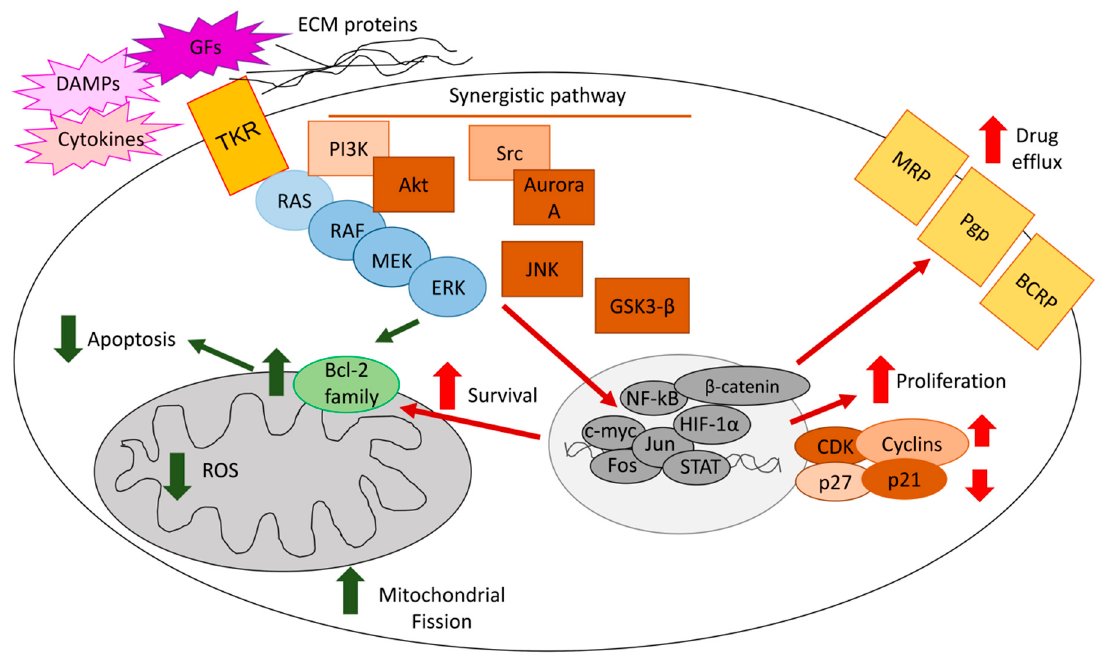
Figure 1. Mechanisms of extracellular signal-regulated kinase (ERK)-induced chemoresistance. The RAS / RAF / MEK / ERK axis [rat sarcoma 2 viral oncogene homolog / rapidly accelerated fibrosarcoma / mitogen-activated protein kinases (MAPK)-extracelluar signal-regulated kinase], upon the activation of tyrosine kinase receptors (TKR) by growth factors (GFs), cytokines, or cell–extracellular matrix (ECM) interaction, cooperates with phosphoinositide 3-kinase (PI3K) / protein kinase B (AKT), c-Jun amino-terminal kinase (JNK), steroid receptor coactivator-1 (Src) / Aurora kinase, glycogen synthase kinase 3- β (GSK-3 β ) / β -catenin signals, activating a pool of transcription factors that determine: (i) increased cell proliferation by up-regulating cyclins and cyclin-dependent kinase (CDKs) and / or down-regulating the cell cycle check-points p21 and p27; (ii) prevention of apoptosis by decreasing Bcl-2 proteins, reducing mitochondrial reactive oxygen species (ROS) and mitochondrial fission; (iii) increased expression and activity of drug e ffl ux transporters, such as P-glycoprotein (Pgp), multidrug resistance related proteins (MRPs), and breast cancer resistance proteins (BCRP). All these mechanisms make a tumor cell more resistant to chemotherapy. Green arrows: apotosis-related mechanisms; red arrow: pro-survival-related mechanisms.